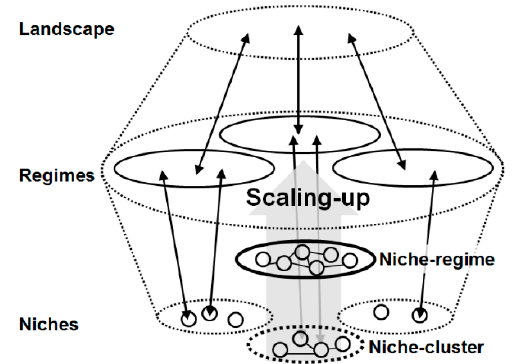
Figure 1. Scaling up from niches to regimes reproduced with permission from Van den Bosch, Transition Experiments: Exploring societal changes towards sustainability; published by Erasmus University Rotterdam, 2010.